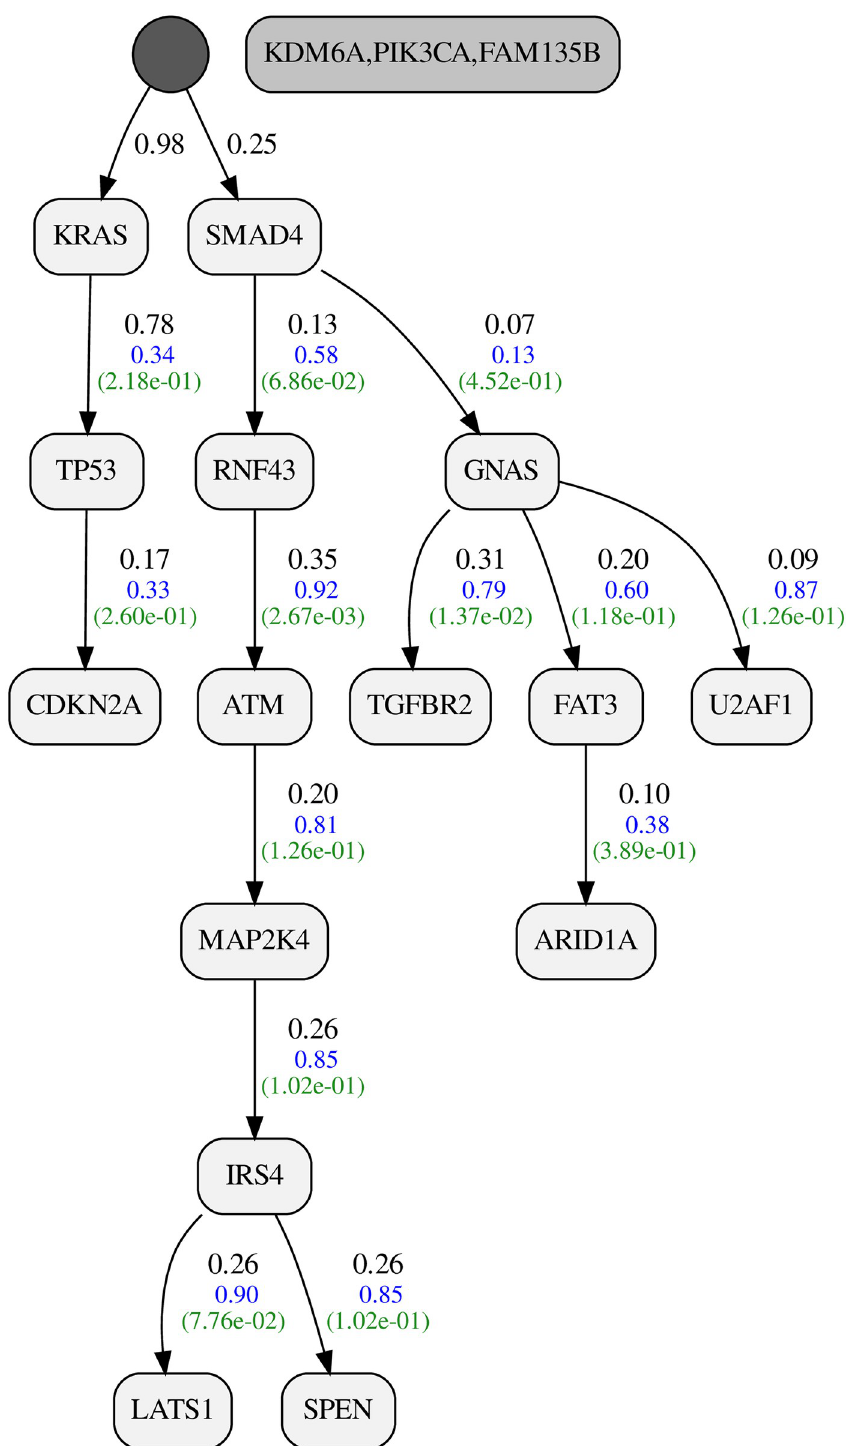
Fig 11. Inferred progression model for Pancreatic adenocarcinoma (PAAD).